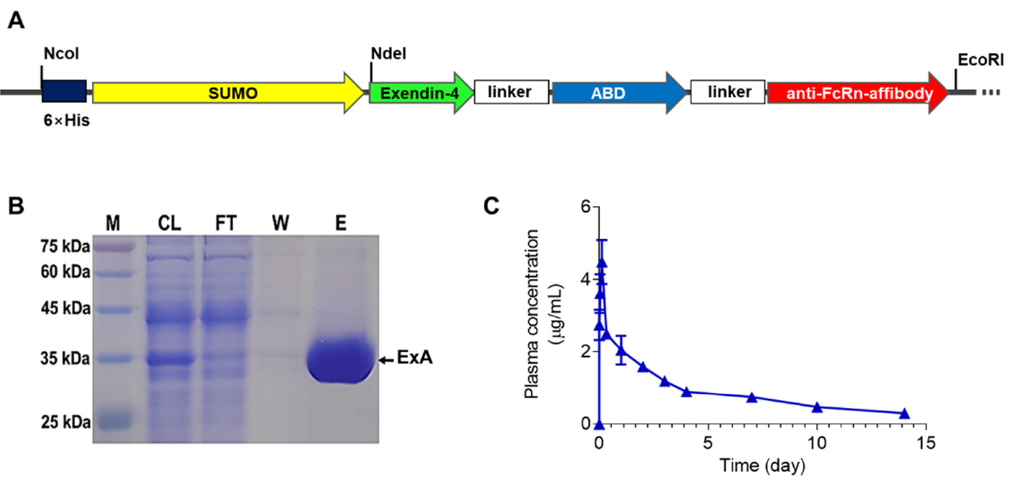
Figure 1. Production and pharmacokinetic (PK) characterization of long-acting exendin-4-ABD-anti-FcRn affibody (ExA). ( A ) Schematic image of the ExA gene. ( B ) SDS-PAGE results of produced ExA: M, a size marker or protein; CL, E. coli cell lysate; FT, flow-through solution; W, washed fraction; E, eluent buffer. ( C ) Plasma concentration-versus-time profiles of the ExA in ICR mice.